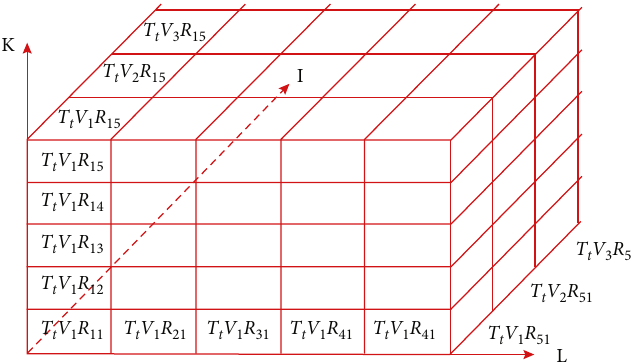
Figure 5: Schematic diagram of the three-dimensional matrix of aviation material scheduling.